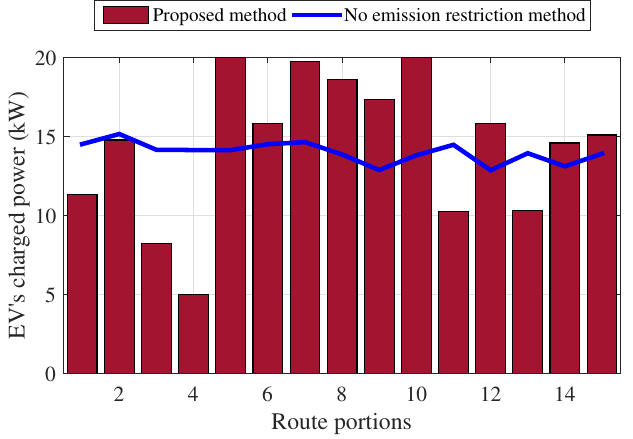
Figure 10. Scheduling results of EVs’ charged power at different route portions.